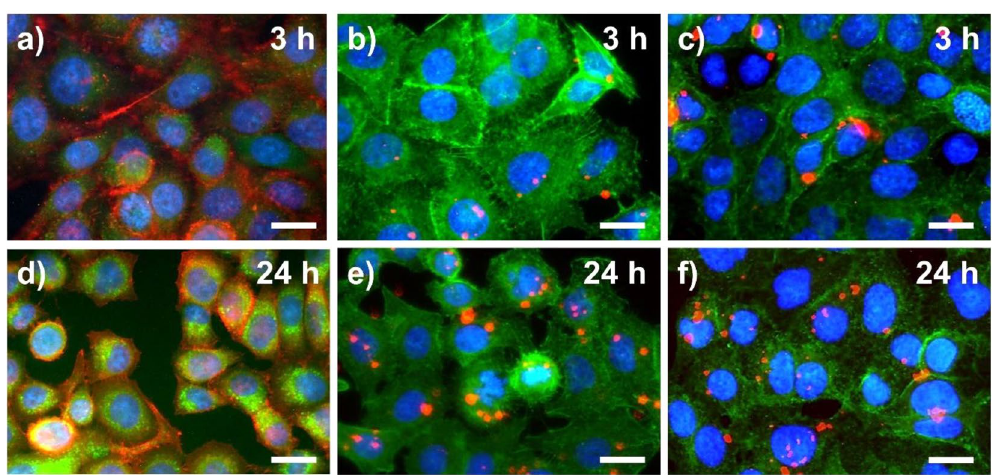
Figure 7. Epifluorescence images of the uptake of optical probe 3 ( a , d ), and the pH nanosensors PSNP-NR- 3 ( b , e ) and SiO 2 -RhB- 3 ( c , f ) by A549 cells measured after different incubation times, 3 h and 24 h, respectively. Prior to the fluorescence microscopy studies, the cells were incubated alive, fixed with 4% paraformaldehyde (PFA), and then co-stained with DAPI (cell nuclei, blue) and partly phalloidin-Alexa 488 (actin filaments, shown in red for ( a , d ) and in green for ( b , c , e , f )) 1:10 dilution of probes dispersed in MilliQ water with PBS buffer. Excitation was carried out with an Osram 50 W/ACL1 Cz HBO Mercury vapor short-arc lamp and the fluorescence was monitored with emission filters set to λ Em = 470 nm (green channel) and to λ Em = 560 nm (red channel). For the detection of the fluorescence of DAPI Leica filter cube A (λ Em = 340/380 nm (blue channel) was used. All images show a scale bar of 10